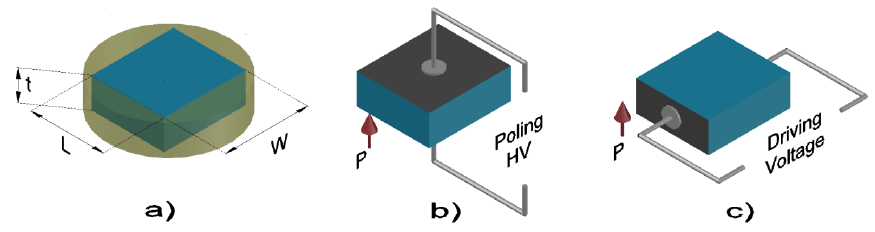
Figure 1. ( a ) The original ceramic disk; ( b ) the shear plate cut from the disk and then thickness ( t ) poled (after poling electrodes were removed and new ones a(cid:308)ached); ( c ) the shear plate excited in the length between electrodes ( w ) of area t x L